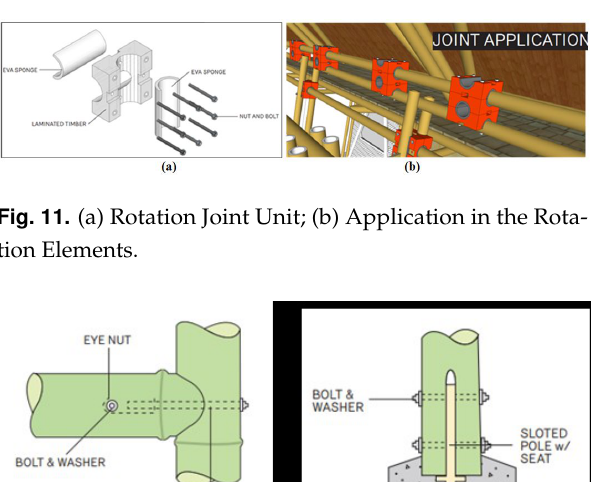
Fig. 10. A scenario of Flexibility of Housing Placement, Orientation, and Massing. Key Plan (left) and Massing (right).